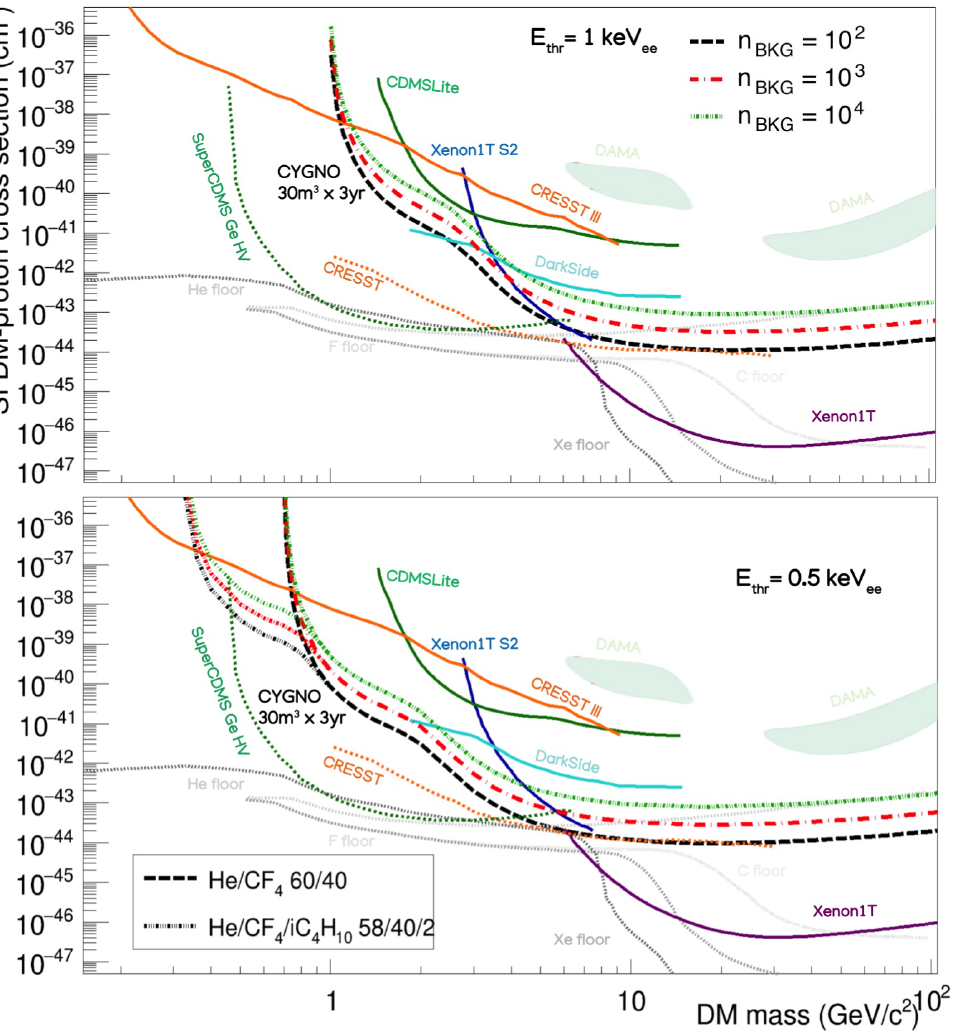
Figure 14. Spin-independent sensitivity for WIMP-nucleon cross-section for 30 m 3 CYGNO detector for 3 years of exposure with different background level assumptions and an operative threshold of 1 keV (top plot) and 0.5 keV (bottom plot). The dashed curves correspond to a HeCF 4 60/40 detector with N bkg = 100 (black), 1000 (red) and 10,000 (dark green). The dotted curves show the sensitivity for a HeCF 4 :isobutane 58/40/2 mixture. Current bounds from Xenon1T (violet) [78], Xenon1T S2 analysis (blue) [79], DarkSide (cyan) [80], CRESST III (orange) [81] and CDMSLite (green) [82] are also shown. The densely dotted curves show the future expected limits of SuperCDMS Ge (green) [83] and CRESST (orange) [84]. The light gray regions denote DM hints by DAMA [85], while the different gray curves show the neutrino background levels for different targets